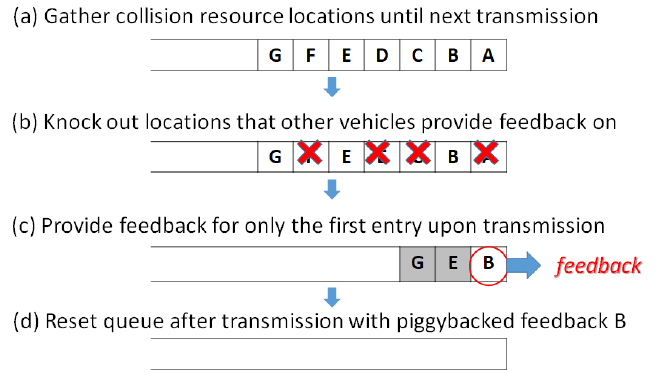
Figure 5. Feedback queue management example: only B is reported as the collision